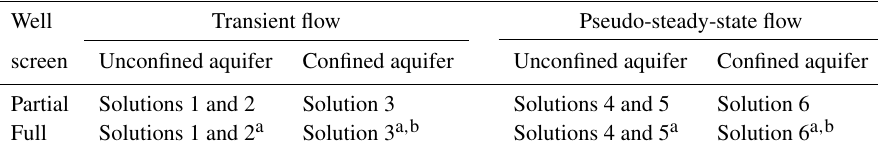
Table 1. The present solution and its special